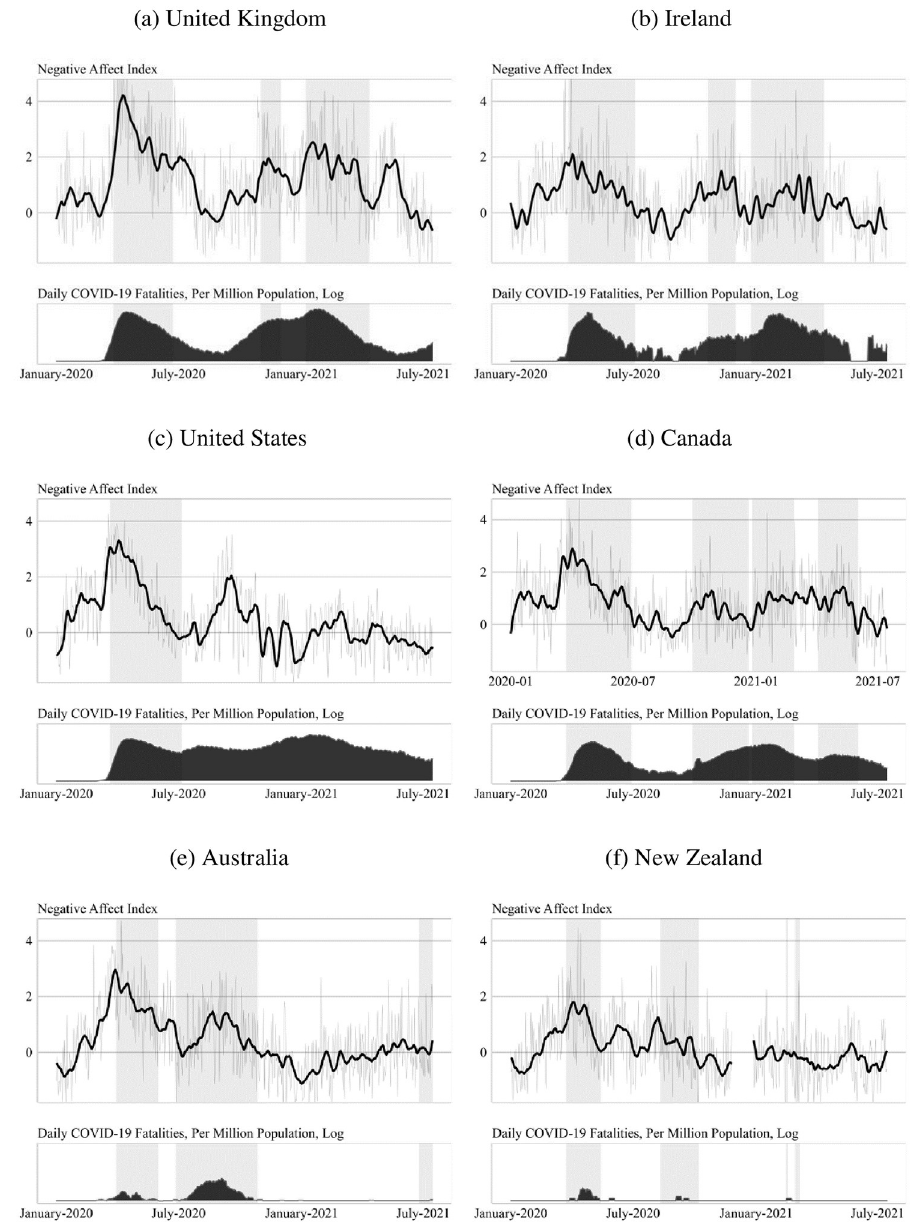
Fig 4. Negative affect, lockdowns and pandemic intensity: Cross-country comparisons, January 2020 to July 2021. (a) United Kingdom (b) Ireland (c) United States (d) Canada (e) Australia (f) New Zealand. Cross-country comparisons on the negative affect Google Trends index. All countries set relative to their pre-pandemic baseline period (15 January to 15 February). Shaded portions indicate periods of lockdown.